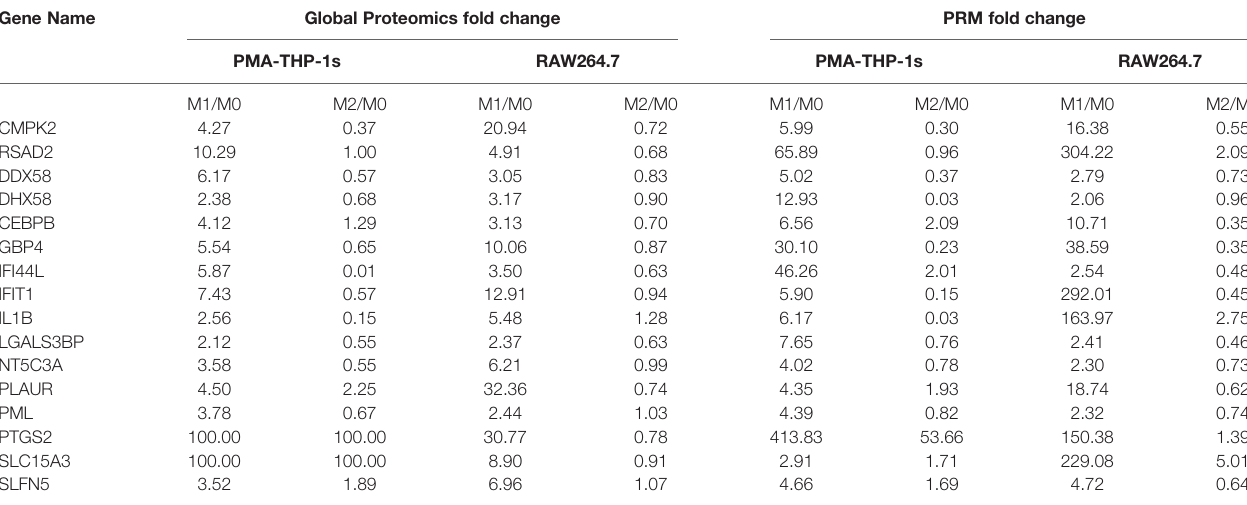
TABLE 1 | Commonly up-regulated proteins changes of M1 polarization in both the THP-1 and RAW264.7 cell models determined by global proteomics and PRM.